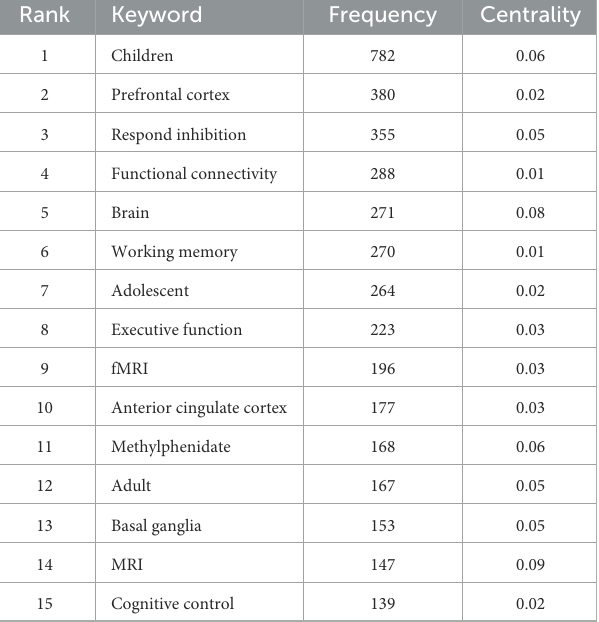
TABLE 7 Occurrences of top 15